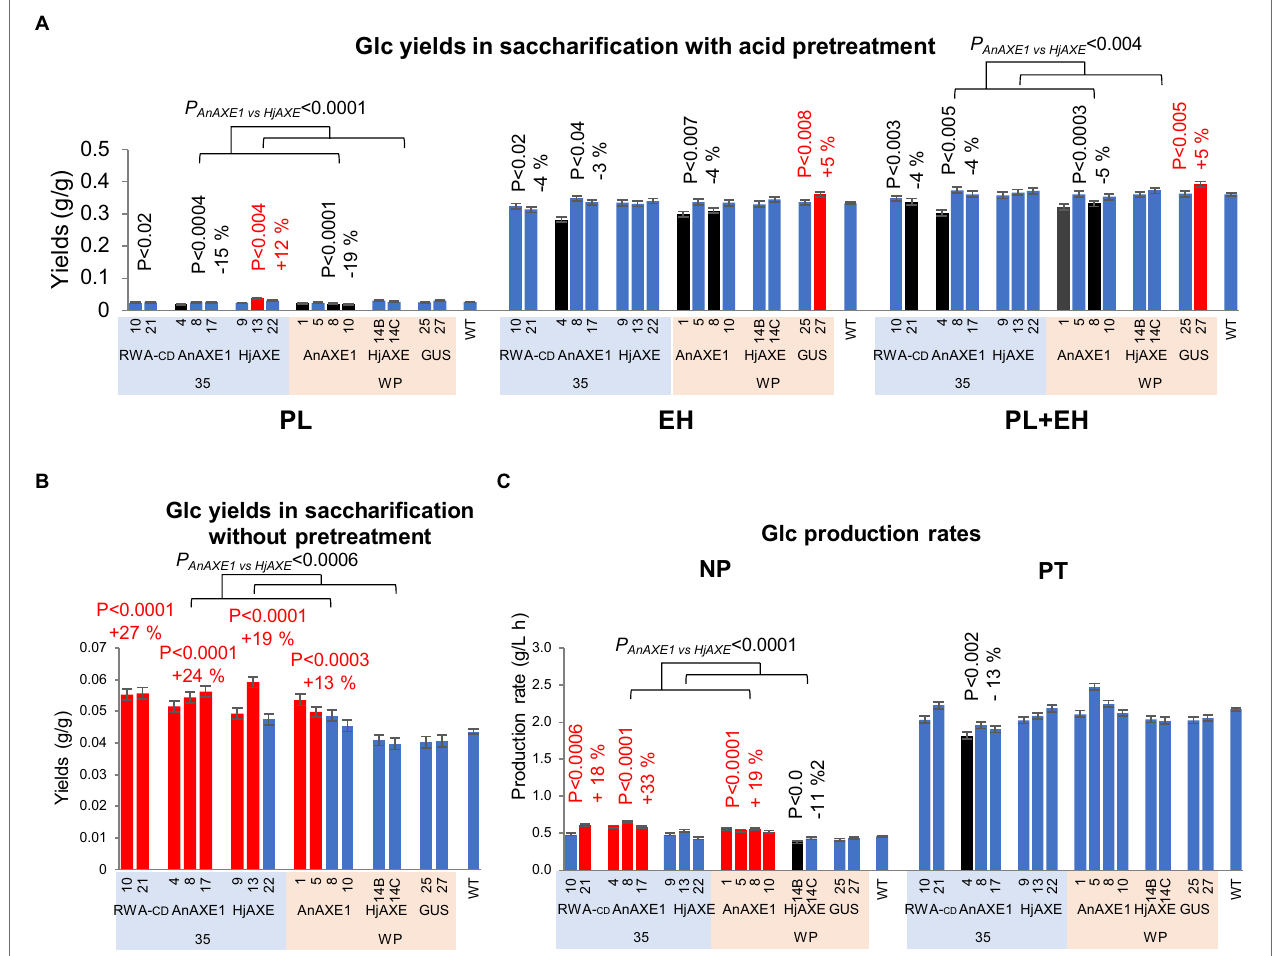
FIGURE 4 | Saccharification parameters of transgenic five-year-old field-grown aspen (glucose yields and production rates). (A) Glucose yields in saccharification with acid pretreatment. PL, pretreatment liquid; EH, enzymatic hydrolysis; and PL + EH, total sugar yield. (B) Glucose yields in saccharification without pretreatment. (C) Glucose production rates. NP, not pretreated; PT, pretreated. Means ± SE . Significant differences according to ANOVA followed by Dunnett’s test ( p < 5%) are indicated by color (red – higher and black – lower, than WT parameters). The values of p show the significance of differences between all the lines carrying indicated constructs and WT plants (post-ANOVA contrast, shown when < 5%). Effects of the transgene ( AnAXE1 vs. HjAXE ) were assessed by ANOVA F-